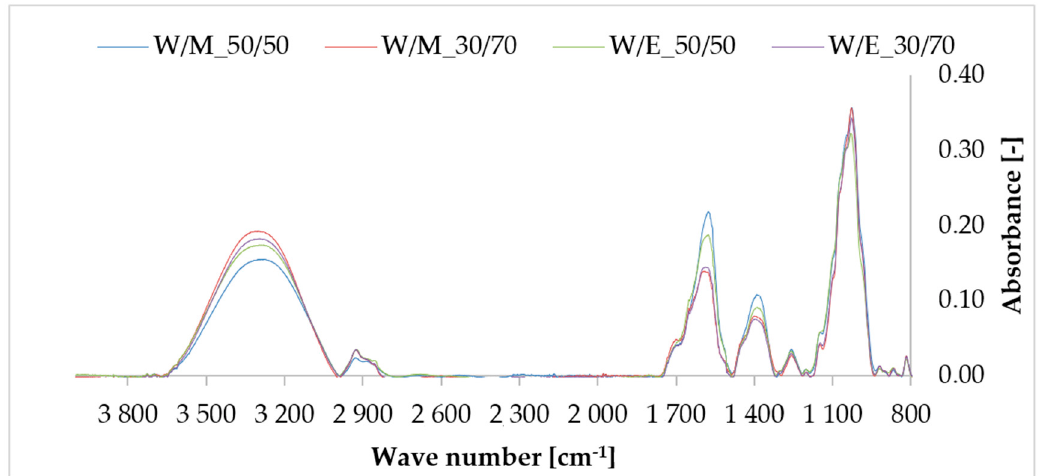
Figure 3. The FTIR spectrum of horsetail extracts.